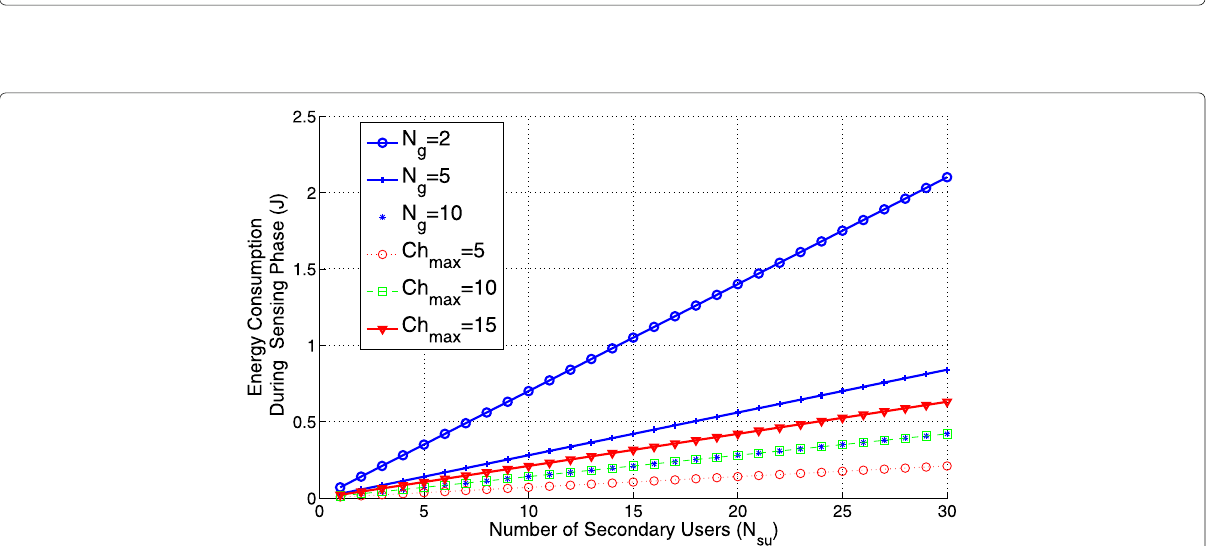
Fig. 11 Energy consumption analysis during parallel sensing phase for N g = 2, N g = 5, and N g = 10 and its comparison, when ch max = 5, ch max = 10, and ch max = 15